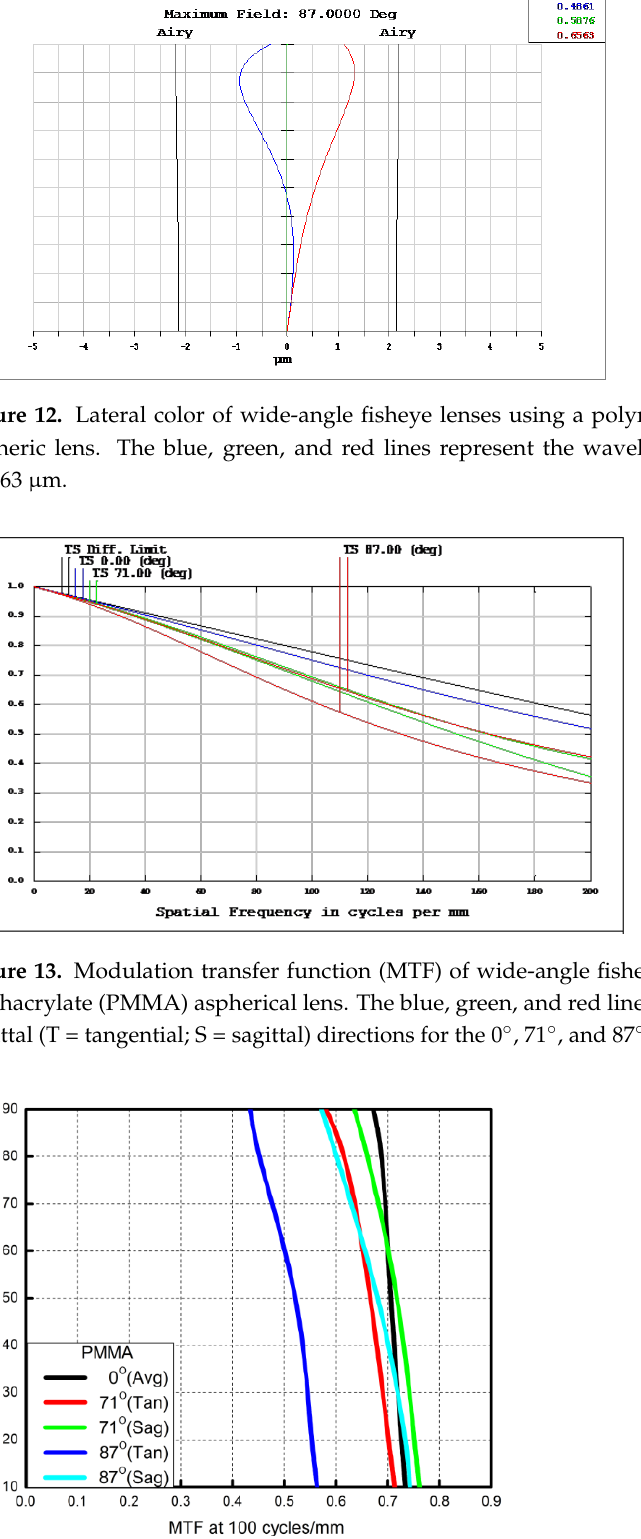
Figure 14. Cumulative probability vs. modulation transfer function (MTF) for fisheye lenses using a polymethyl methacrylate (PMMA) aspherical lens. For the cumulative probability of 90%, the tangential MTF values at the half field of view for the 0°, 71°and 87°cases correspond to 0.67, 0.58, and 0.43, respectively.